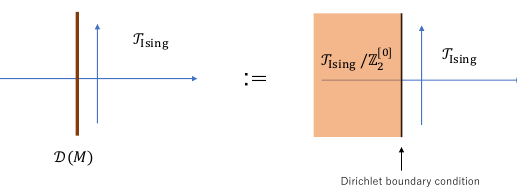
Figure 2. Schematic picture of the definition of the Kramers-Wannier duality defect in the 2d critical Ising model. Because of the invariance under the gauging (5), the interface between T Ising / Z 2 and T Ising gives the T Ising with a co-dimension-1